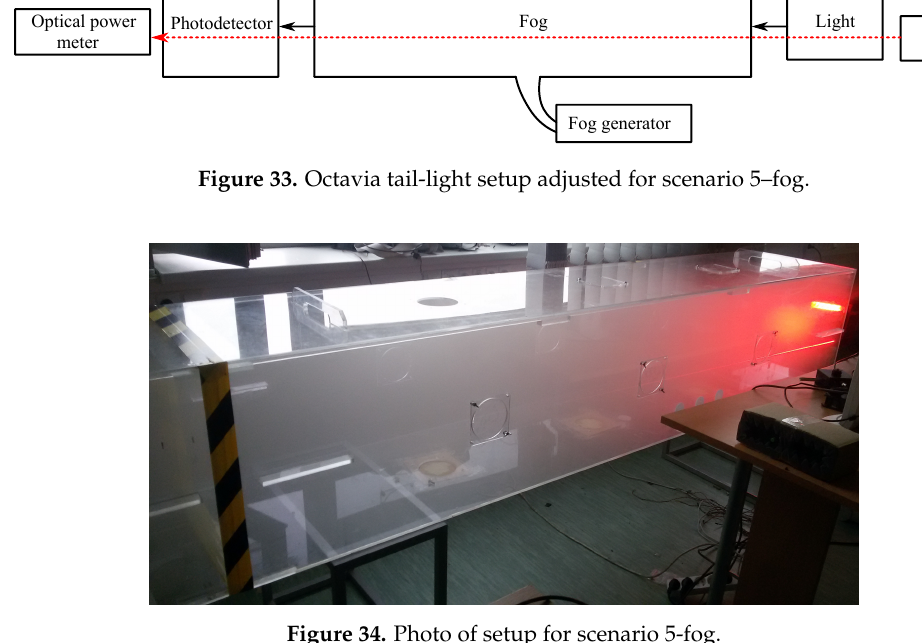
Figure 34. Photo of setup for scenario